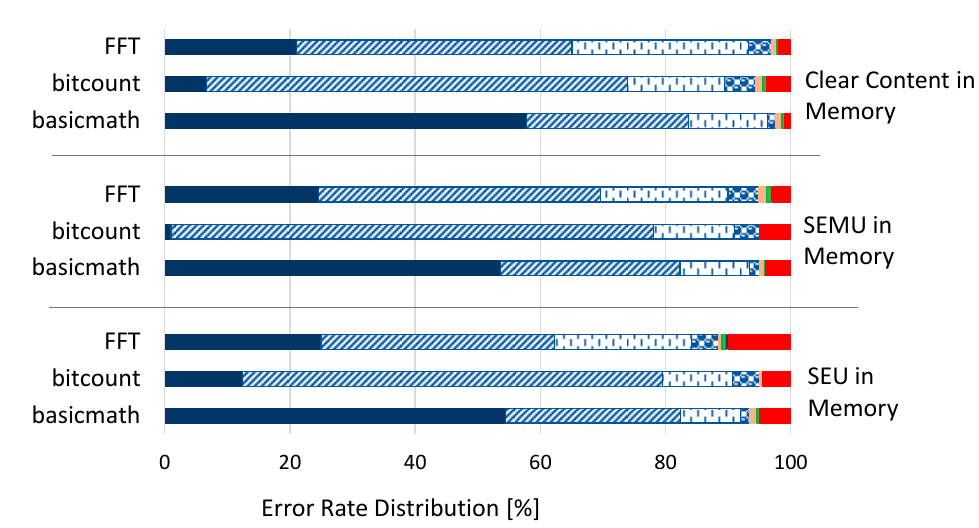
Figure 8. The error rate distribution for the SEE fault injection campaigns in memory.